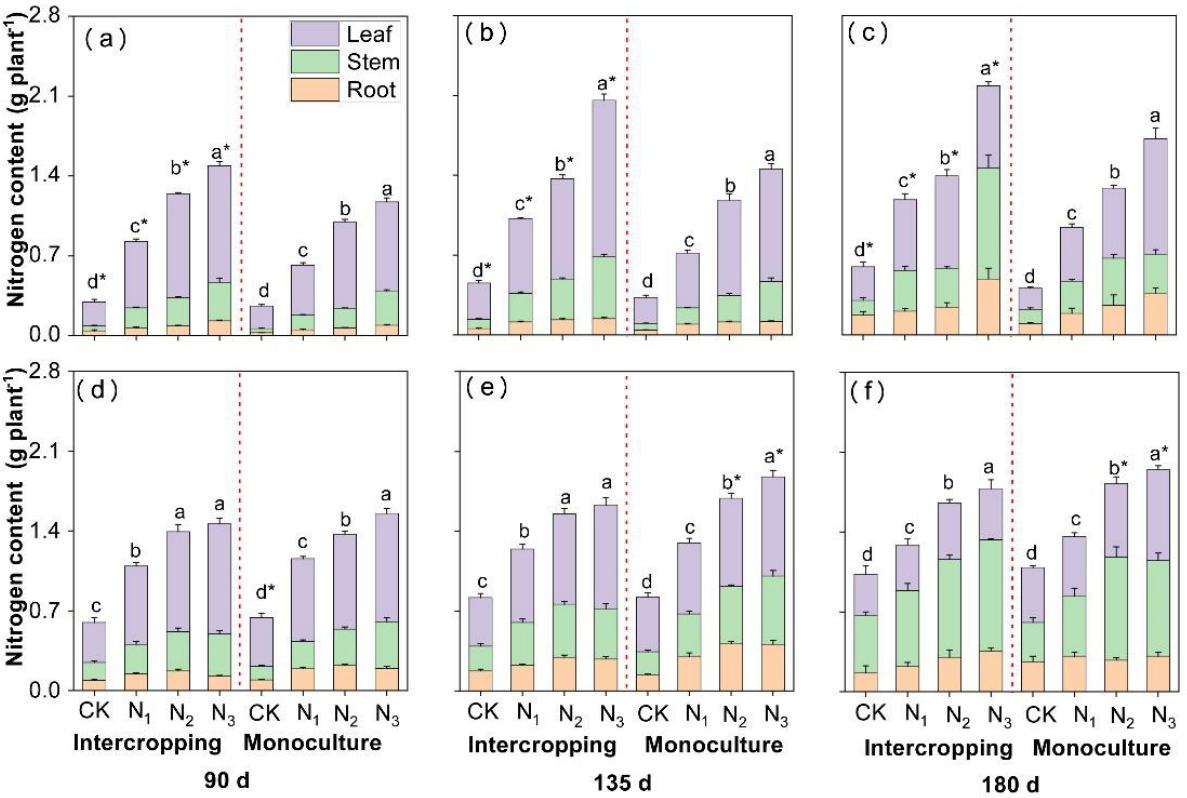
Figure 3. The effects of N application and the planting system on N accumulation in intercropped and monocropped E. urophylla × grandis ( a – c ) and D. odorifera ( d – f ). CK indicates plants without N application, and N 1 , N 2 , and N 3 correspond to N fertilizer application rates of 3, 6, and 12 g urea (CO( 14 NH 2 ) 2 ) pot −1 , respectively. The different lowercase letters above the bars indicate significant differences ( p < 0.05) in whole-plant N accumulation among the N treatments within each planting system. * indicates a significant difference ( p < 0.05) in E. urophylla × grandis or D. odorifera between intercropped and monocropped plants. Error bars indicate ± SE ( n = 4).